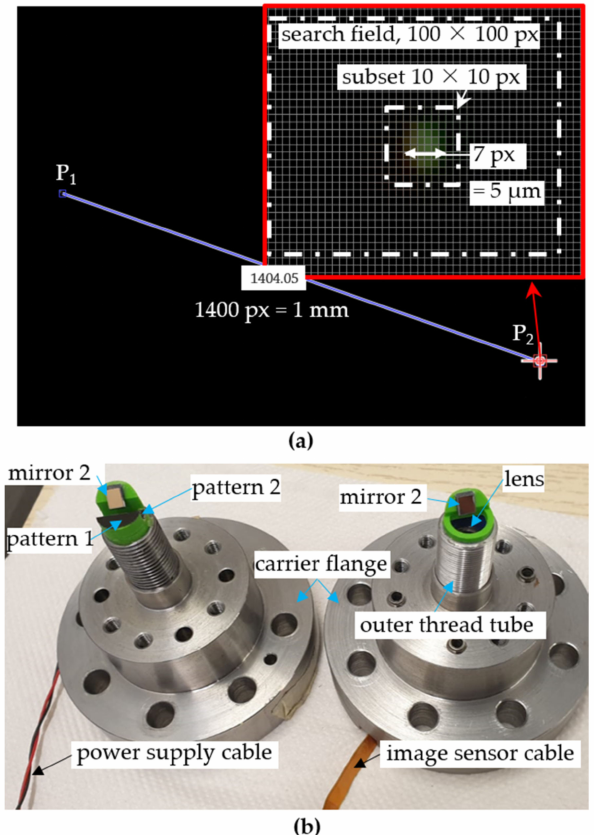
Figure 6. ( a ) Design features of the photomask for the direct image segment and adjusted DIC algorithm parameters, ( b ) carrier flanges with both senor